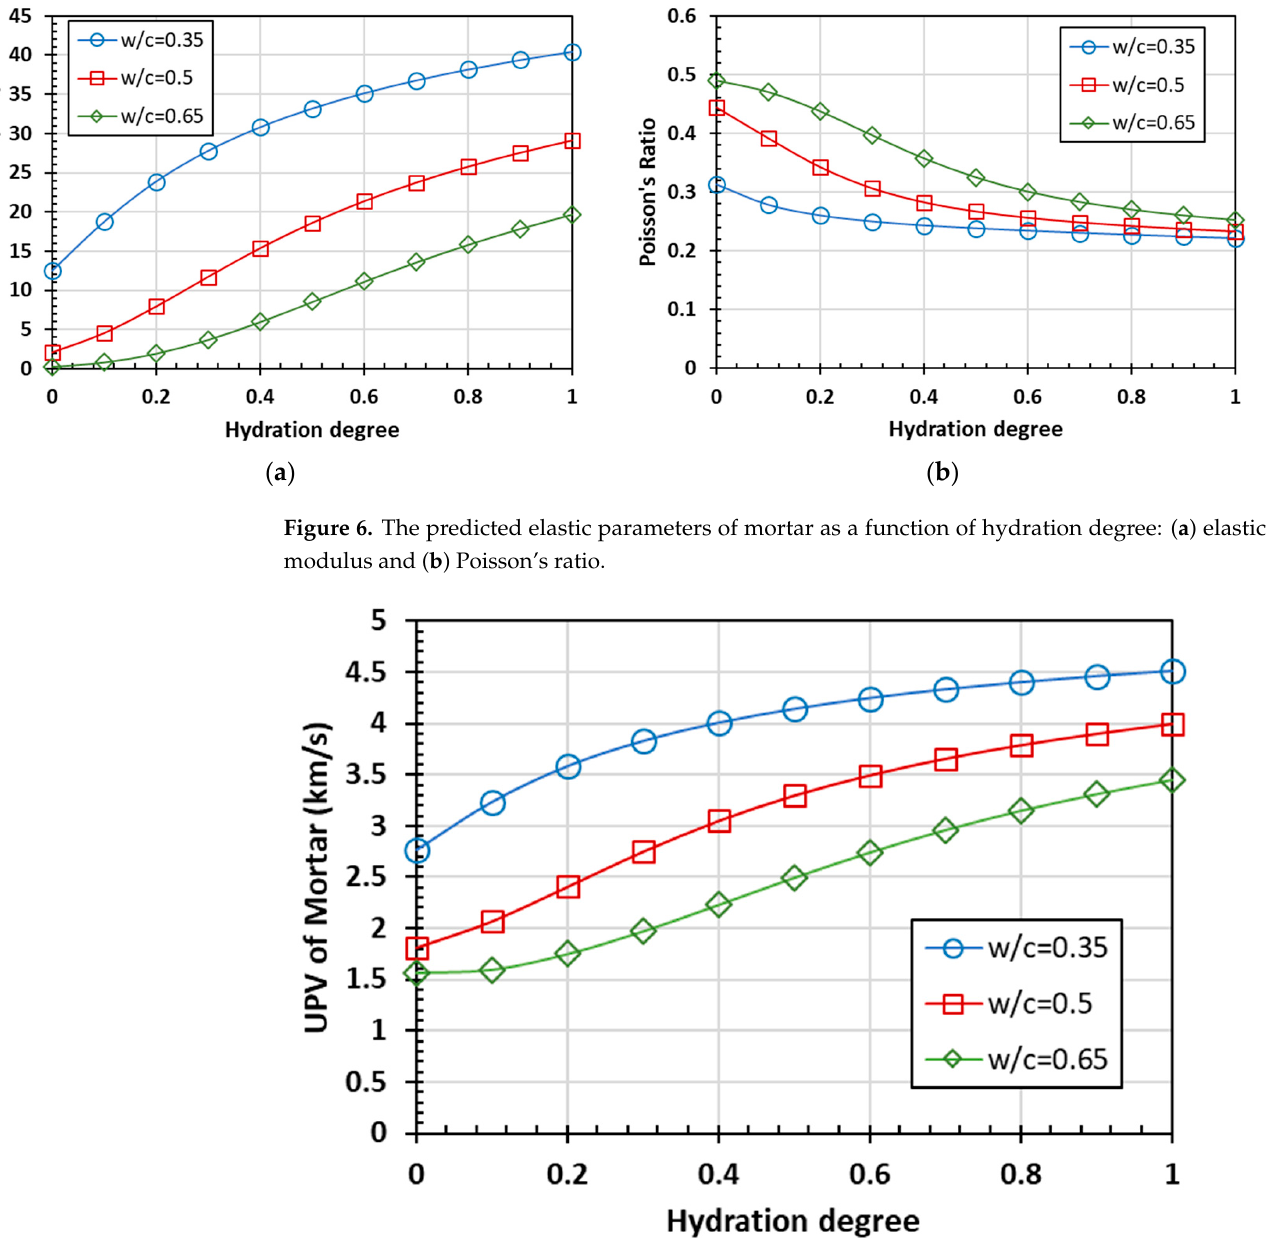
Figure 7. The ultrasonic pulse velocity prediction of mortar.